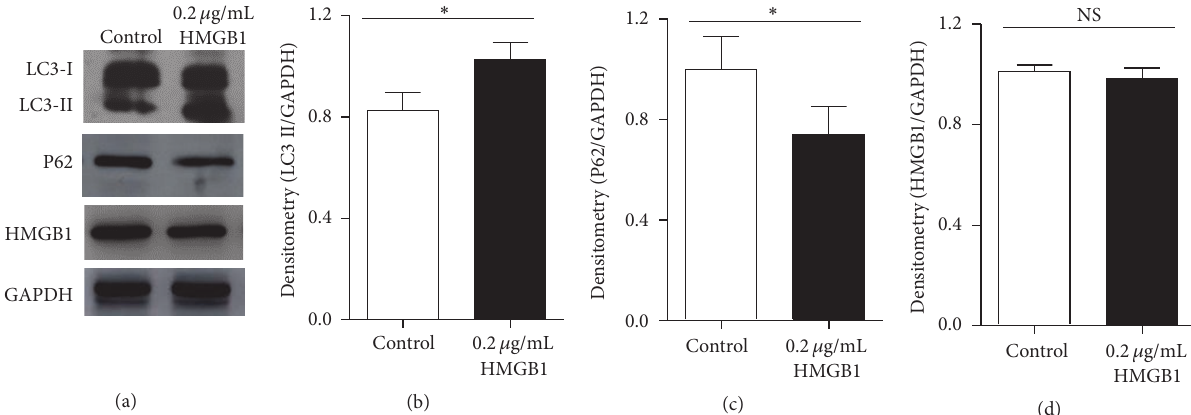
Figure 2: Exogenous HMGB1 activated autophagy. 3T3-L1 preadipocytes were treated with HMGB1 protein (0.2 𝜇 g/mL) or PBS for 24 h accordingly. (a) Total protein was extracted, and LC3II, P62, and HMGB1 proteins were analyzed by western blot. (b–d) LC3II, P62, and HMGB1 protein were quantified and normalized to GAPDH, ∗ 𝑃 < 0.05 versus the control. NS: not significant.